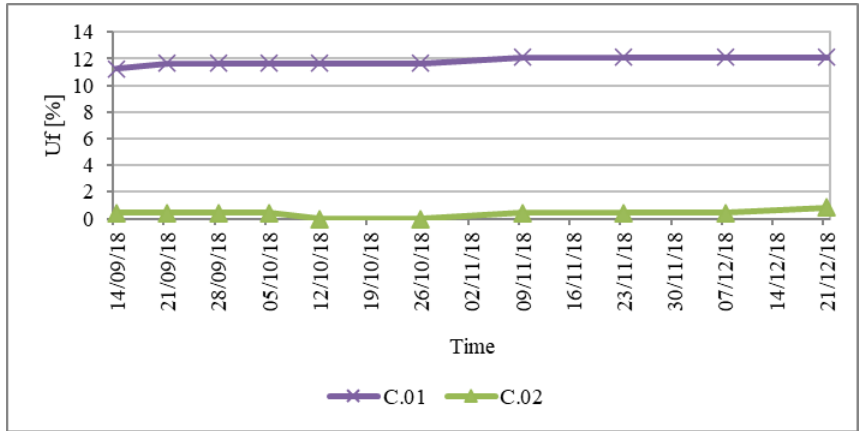
Figure 7. Moisture-time absorption curves for carparo blocks (C.).